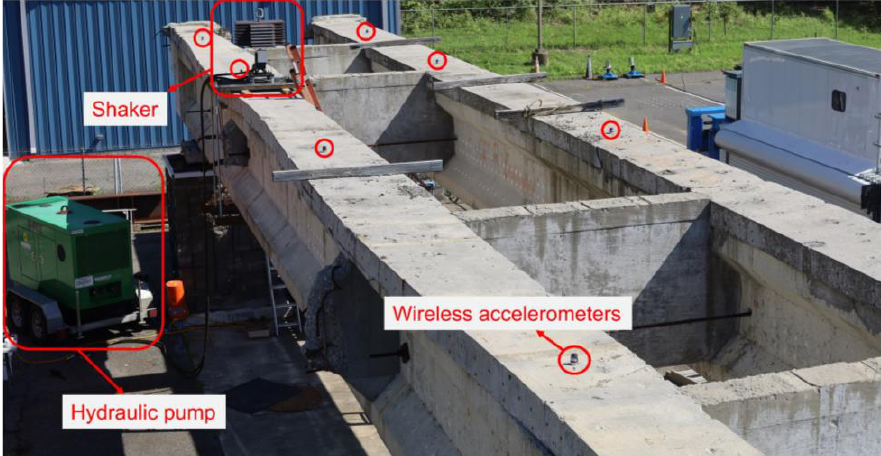
Figure 6. The field experiment setup corresponding to layout 2 (See Figure 4).